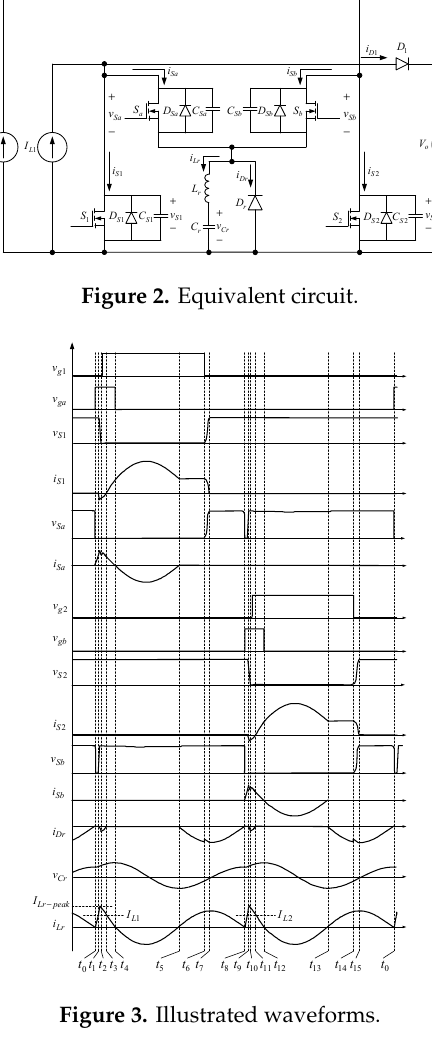
Figure 3. Illustrated waveforms.